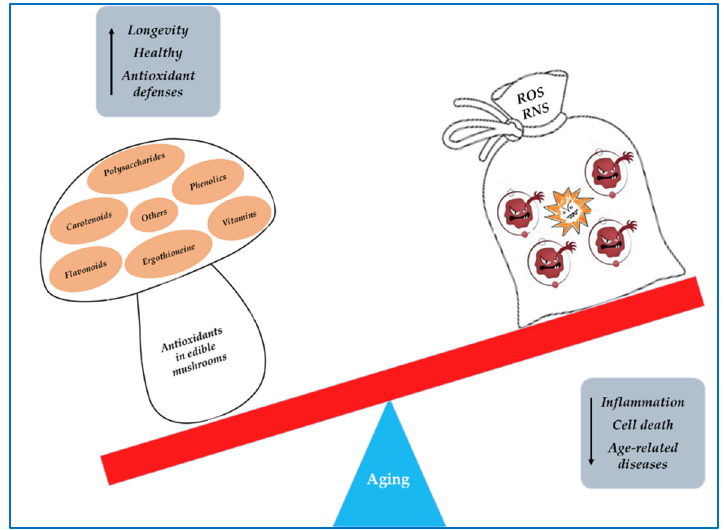
Figure 6. Chemical structure of glutathione.